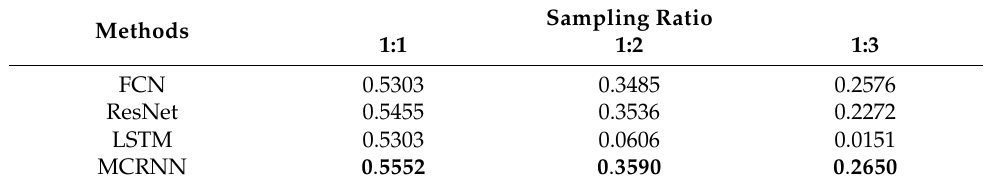
Table 7. Recall-Abnormal comparison between the proposed model and the other baseline methods.